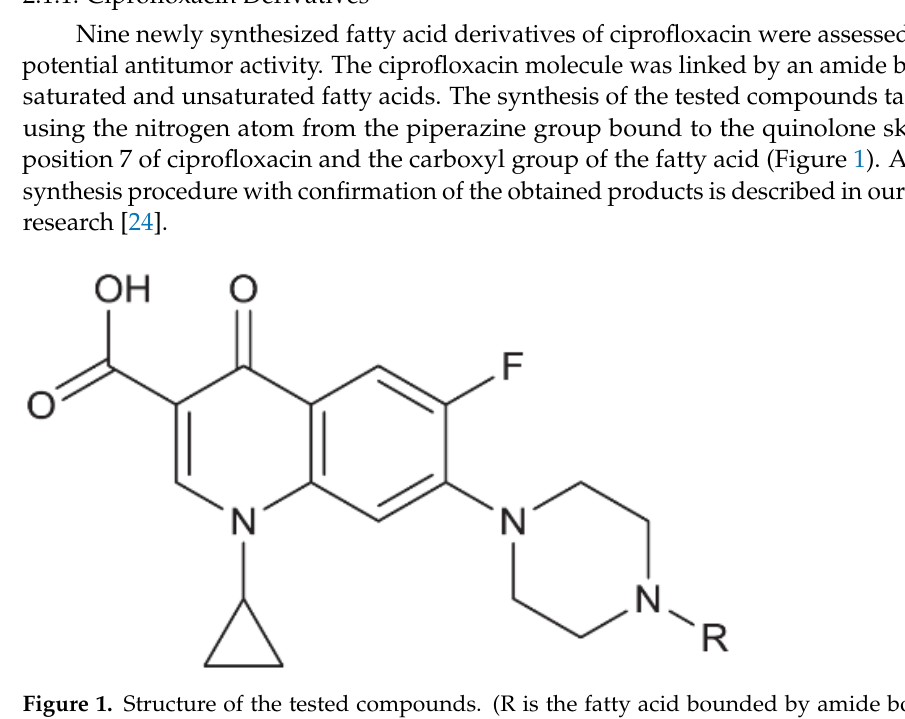
Figure 1. Structure of the tested compounds. (R is the fatty acid bounded by amide bond to the ciprofloxacin molecule.)